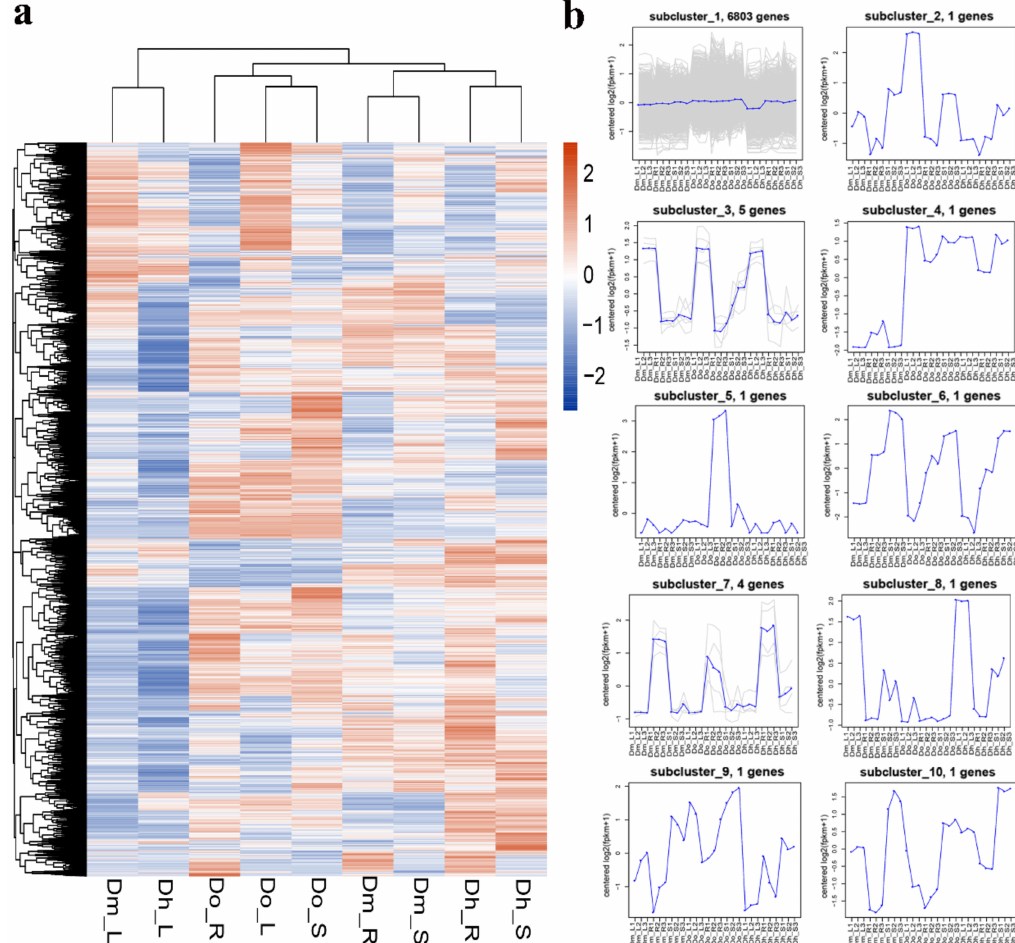
Figure 4. Expression profiles of all DEGs. ( a ) The heatmap of DEGs and the FPKM distribution of all unigenes obtained by hierarchical cluster analysis. Each column in the figure represents a sample, and each row represents a gene. The colors in the graph indicate the magnitude of gene expression (log 10 (FPKM + 1)) in the sample. Red indicates that the gene is highly expressed in the sample, and the blue indicates that the gene expression is low. ( b ) K-means clustering analysis of gene expression profiles. The blue line represents the expression model. The gray lines are the expression profiles of each DEGs. The x-axis represents di ff erent tissues of di ff erent Dendrobium plants. The y-axis represents log 2